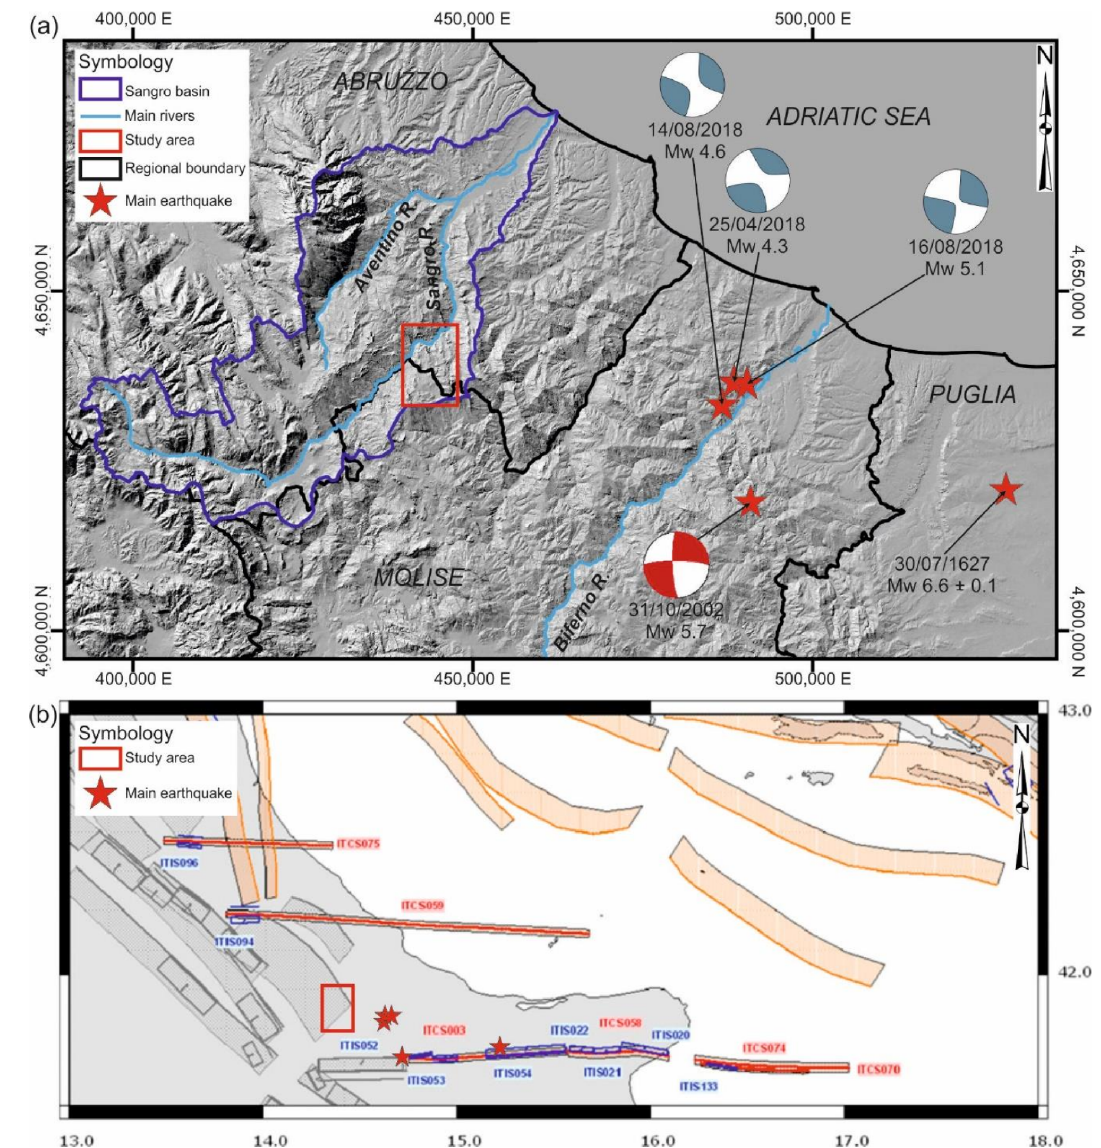
Figure 13. ( a ) Historical and recent earthquakes near the study area, connected to E–W structures, as indicated by focal mechanism. ( b ) E–W deep tectonic structure near the study area and recent earthquakes (modified from